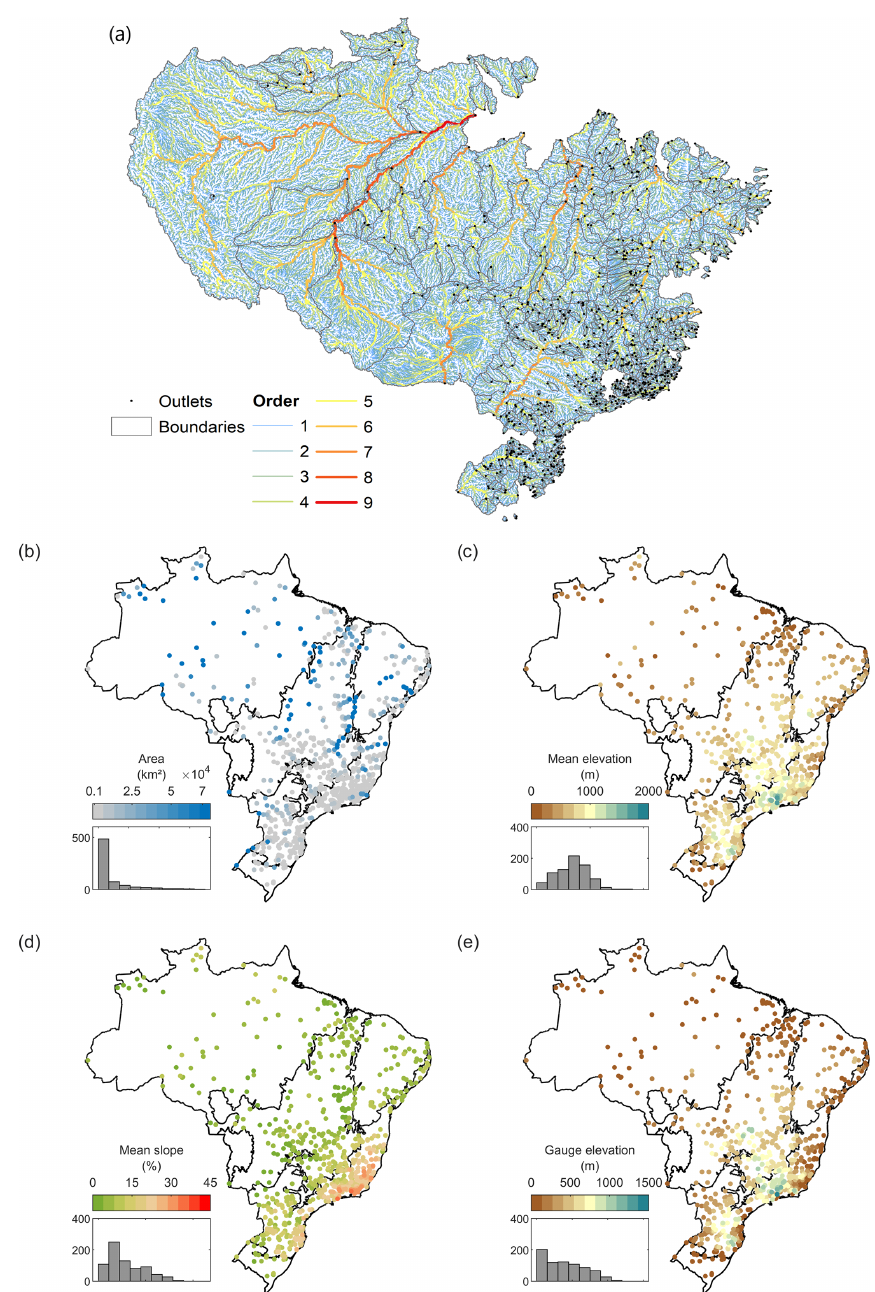
Figure 3. Spatial distribution of the topography attributes of the CABra catchments. (a) Stream order of Brazilian rivers; (b) area of the catchments (in km 2 ); (c) mean elevation of the catchments (in m); (d) mean slope of the catchments (in percent); (e) elevation of the streamflow gauge (in